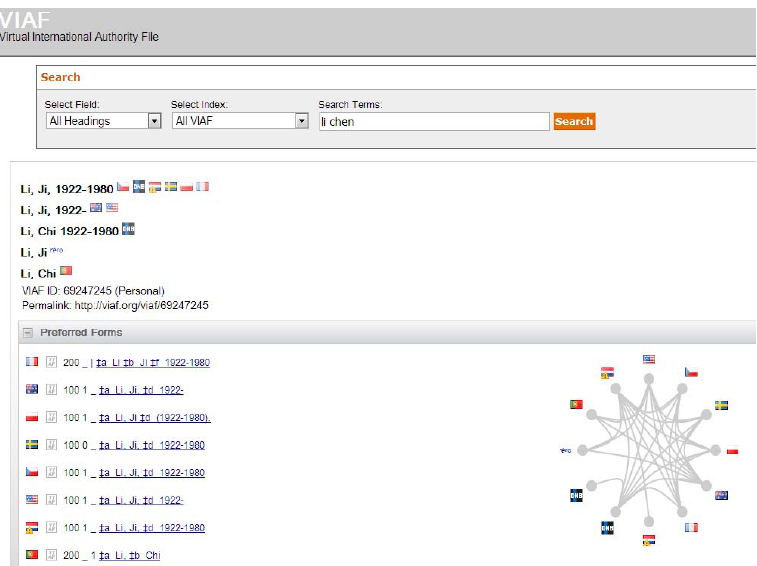
Figure 1. Author representation in Virtual International Authority File